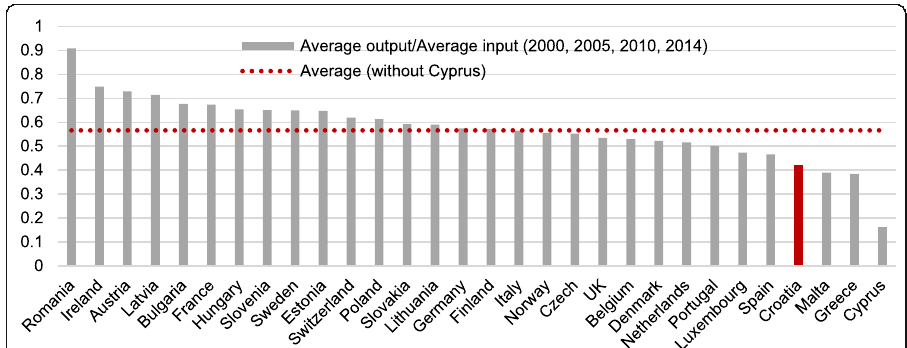
Fig. 2 Nitrogen Use Efficiency (NUE). (Source: Eurostat (2016). Agri-environmental indicators, Pressures and risks - Gross Nutrient